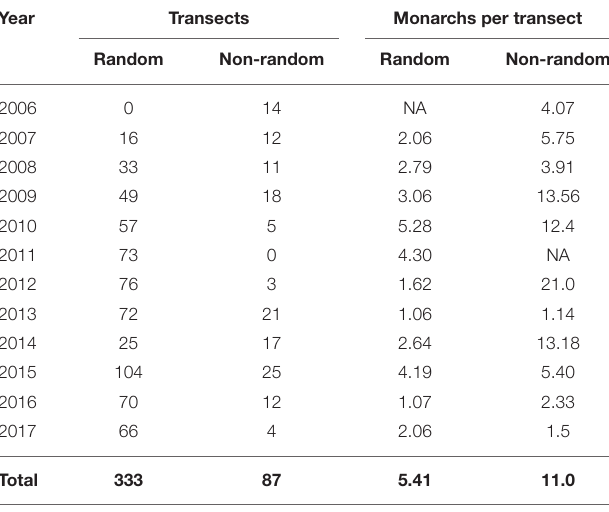
TABLE 1 | Total number of random and non-random transects surveyed and the average number of monarchs seen per transect in Iowa, 2006–2017.